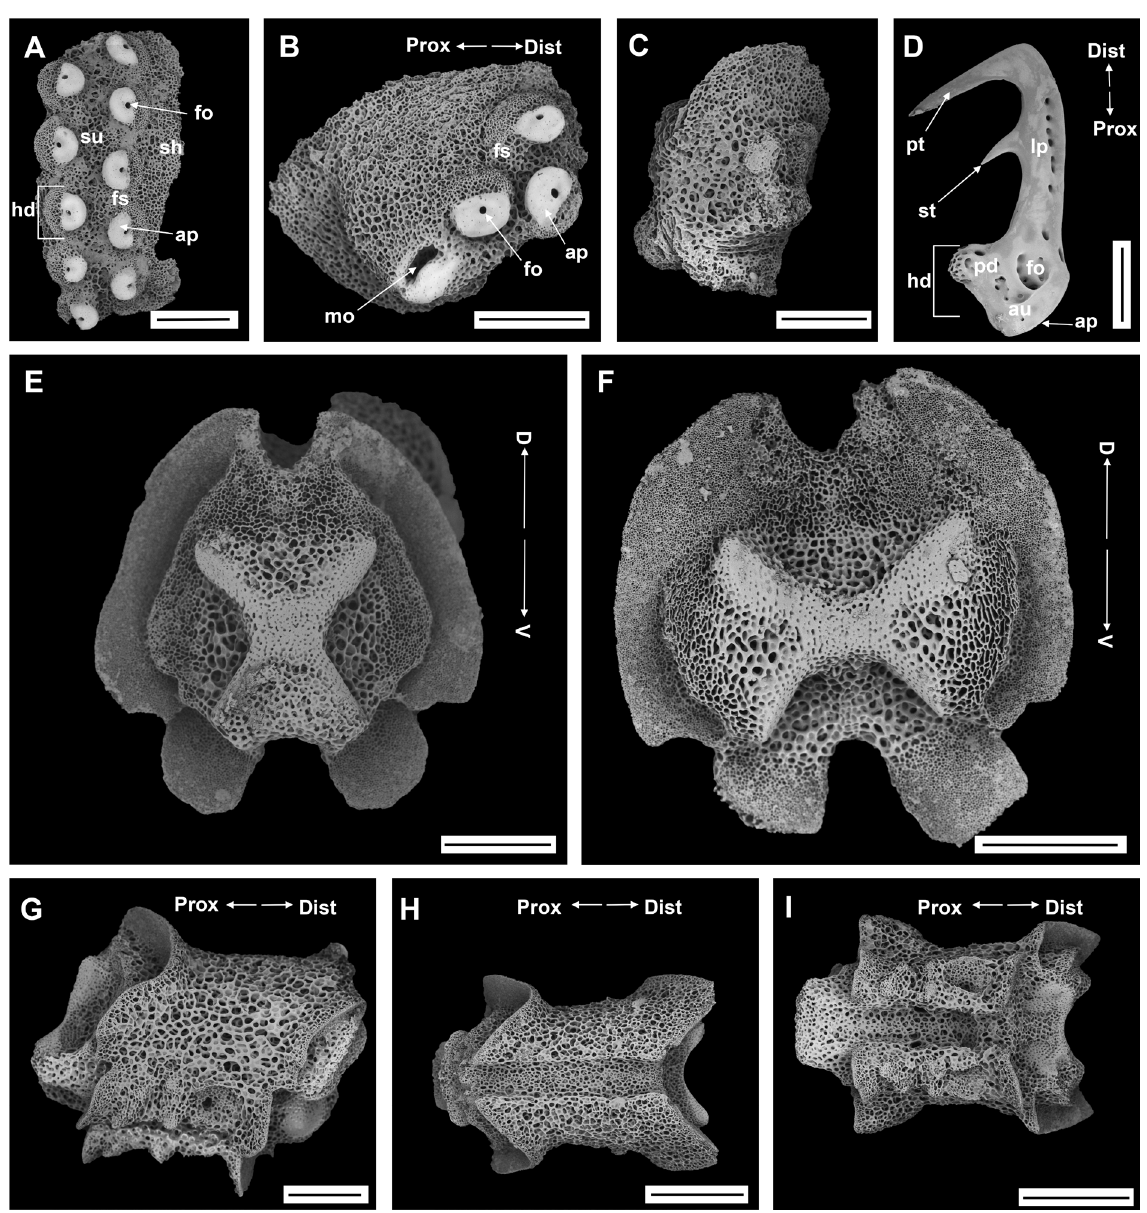
Fig. 12. Gorgonocephalus cf. dolichodactylus Döderlein, 1911, SEM (IDSSE EEB-SW0006). A . Plan view of base plate. B . Distal view of base plate. C . Internal view of base plate. D . Pedicellaria in the pedicellarial band. E–I . Vertebrae. E . Proximal view. F . Distal view. G . Lateral view. H . Dorsal view. I . Ventral view. Abbreviations: ap = articular pad of the base; au = auricle; D = dorsal; Dist = distal; fo = foramen of the base; fs = fossa between adjacent tubercles; hd = head of the apophysis; lp = lateral pores of the blade; mo = muscle opening; pd = pedicel of the apophysis; Prox = proximal; pt = primary tooth of the blade; sh = sheath of the base plate; st = secondary tooth; su = sulcus of tubercle head; V = ventral. Scale bars: A–C, E–F = 300 µm; D = 100 µm; G–I = 500